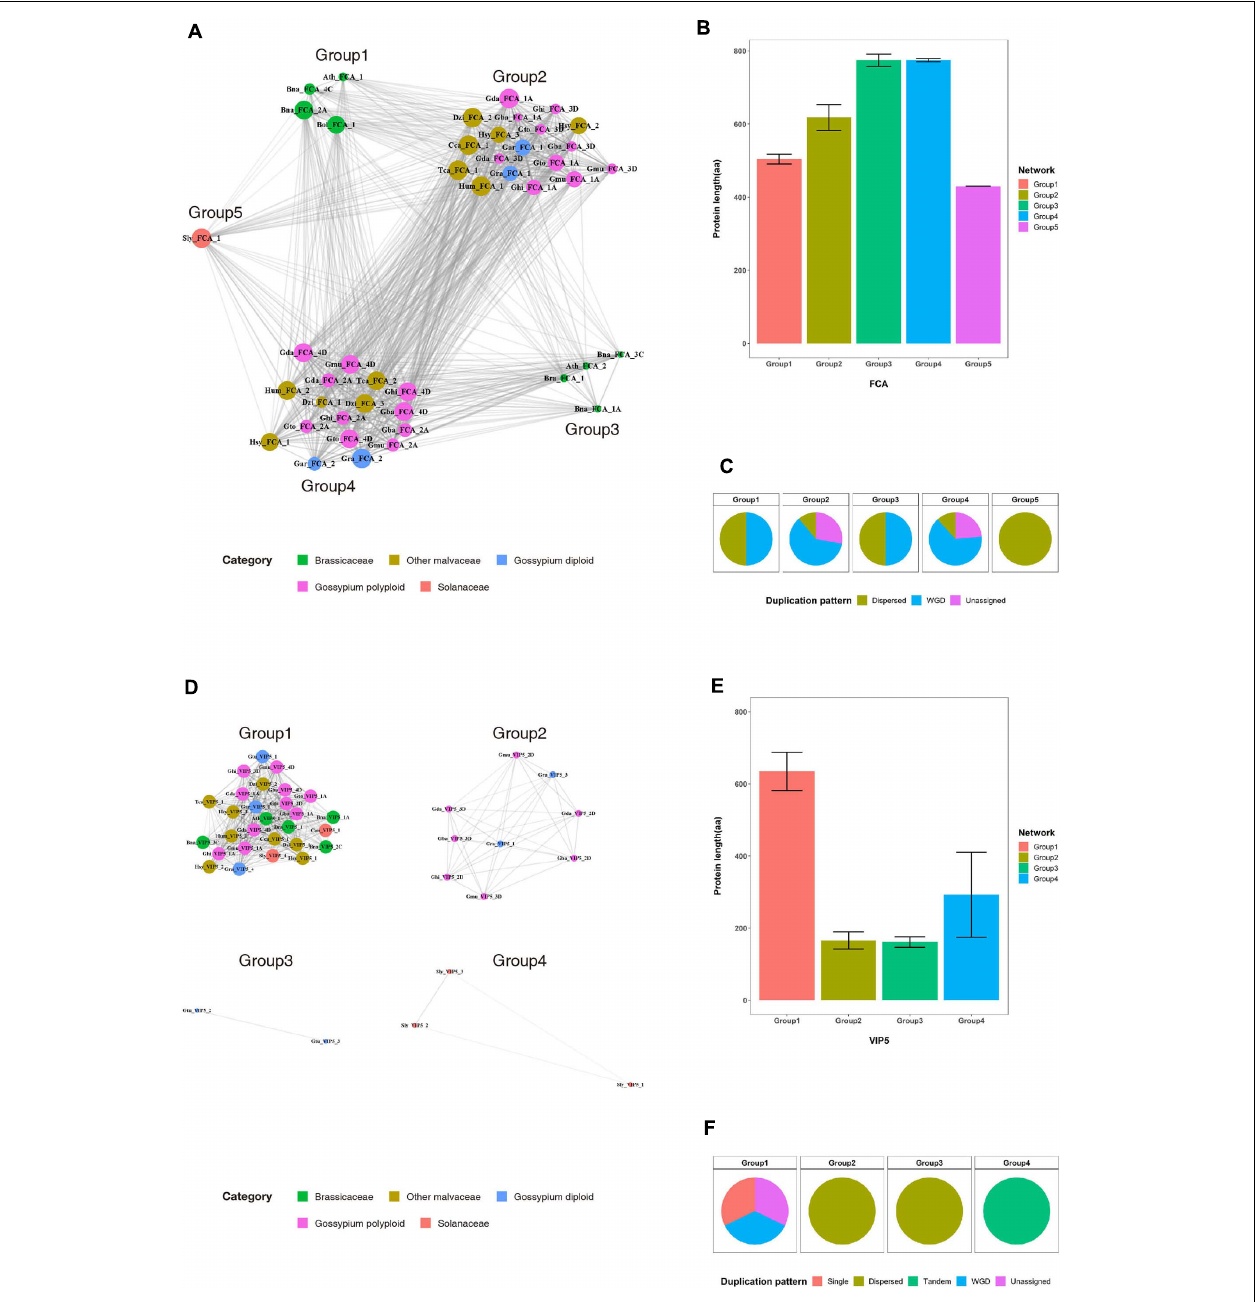
FIGURE 5 | Sequence similarity network analysis for the FCA and VIP5 gene products in the Brassicaceae, Malvaceae, and Solanaceae families. (A) and (D) Sequence similarity networks of the (A) FCA and (D) VIP5 gene products. (B) and (E) Average protein lengths of (B) FCA and (E) VIP5 within individual groups. (C) and (F) Distribution of duplication patterns for (C) FCA and (F) VIP5 within individual